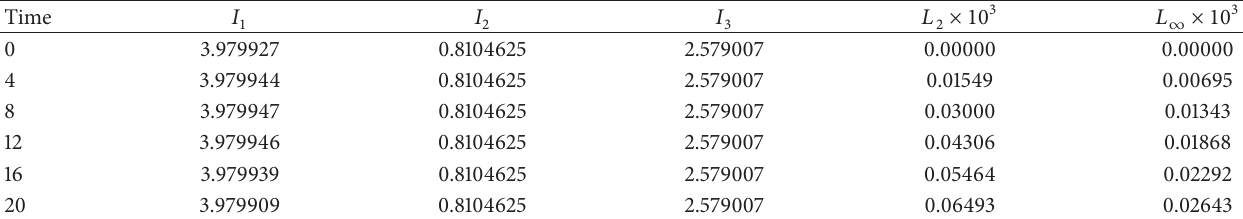
Table 1: Table of values obtained by Avilez-Valente and Seabra-Santos [6] using a Petrov-Galerkin finite element method. Time